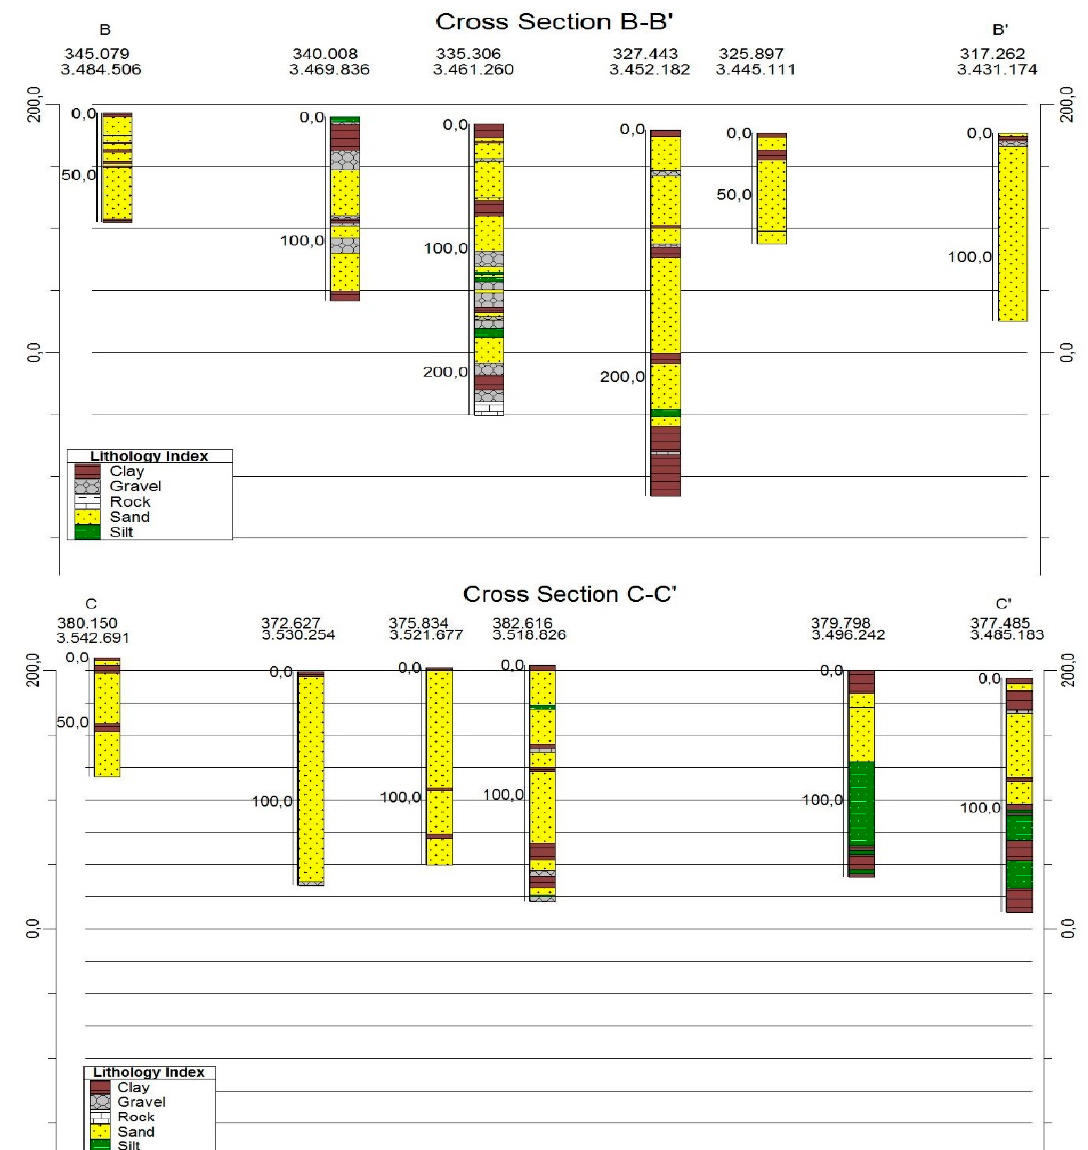
Figure 3. 3-D view of well logs, location of well logs and lithological details of selected well logs at each X-section of LCC.